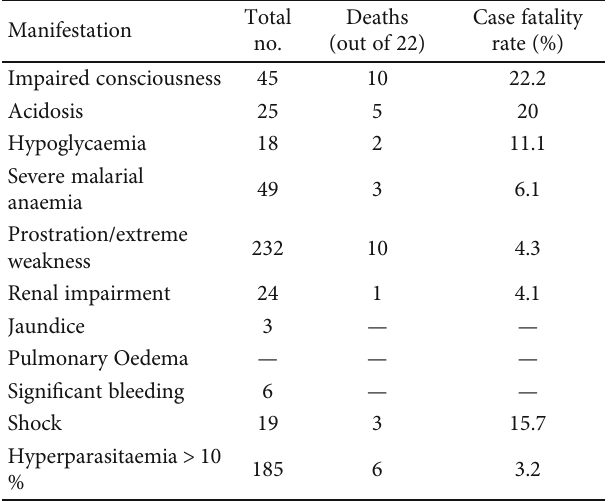
Table 5: Manifestations involved and mortality in severe malaria